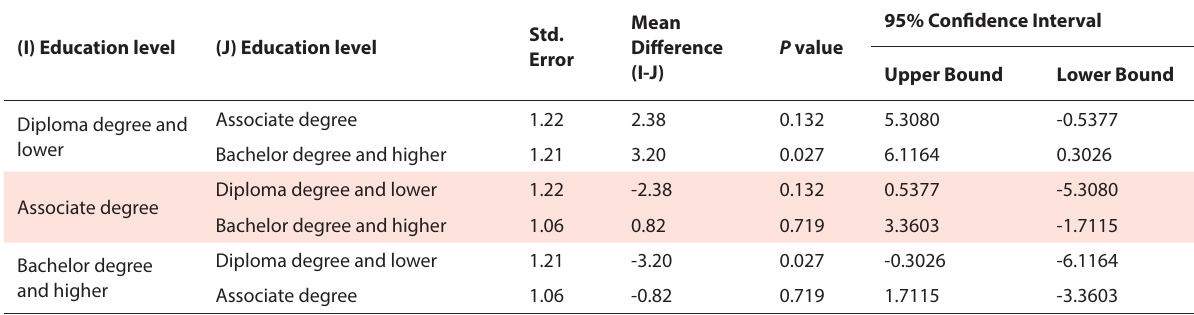
Table 3. Comparison the level of personnel education with their awareness